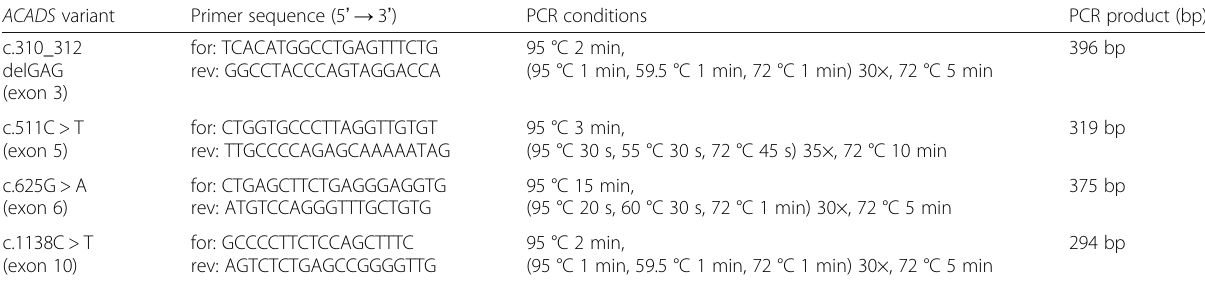
Table 1 Primer sequences and PCR conditions ACADS